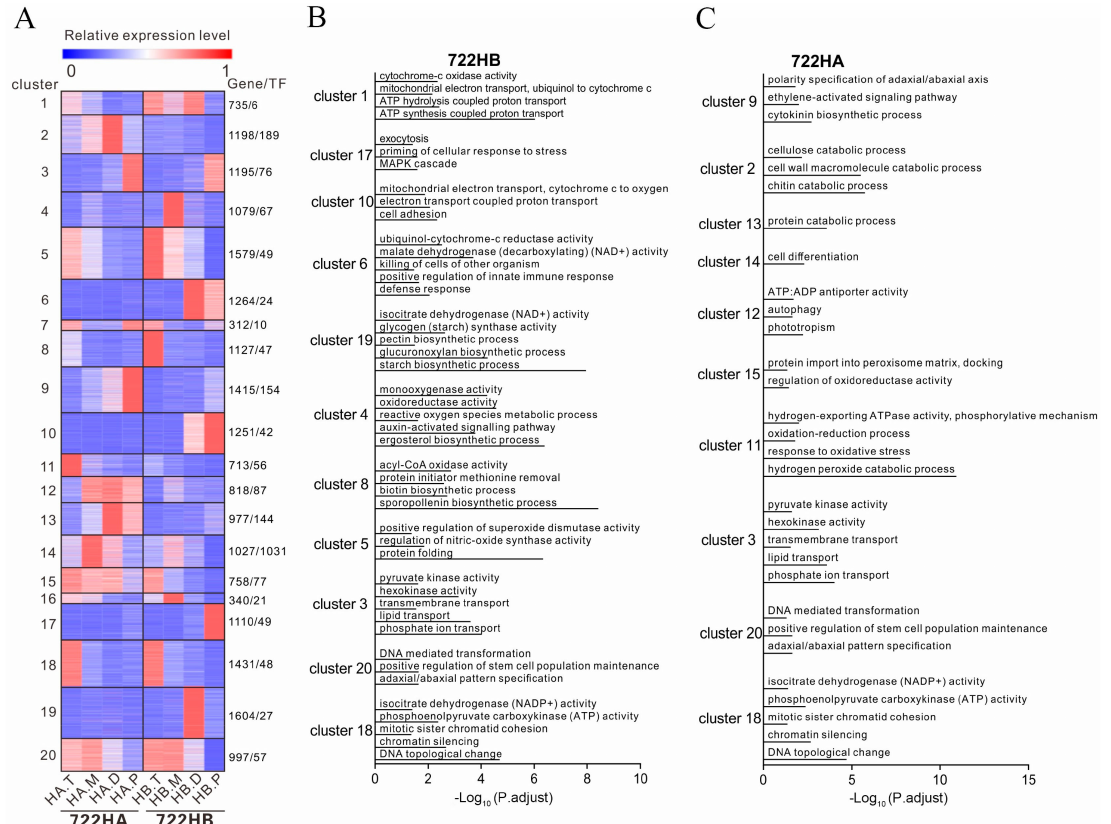
Figure 5. Results of K-means clustering. ( A ) Heat diagram of K-means clustering. ( B ) Gene Ontology (GO) enrichment result of the highly expressed set of genes in 722HB. ( C ) GO enrichment result of the highly expressed set of genes in 722HA. HA.T, HA.M, HA.D, and HA.P correspond to microspores of the tetrad, mononuclear, dinuclear, and mature pollen grains stage, respectively, in 722HA; HB.T, HB.M, BA.D, and HB.P correspond to microspore of the tetrad, mononuclear, dinuclear, and mature pollen grains stage, respectively, in